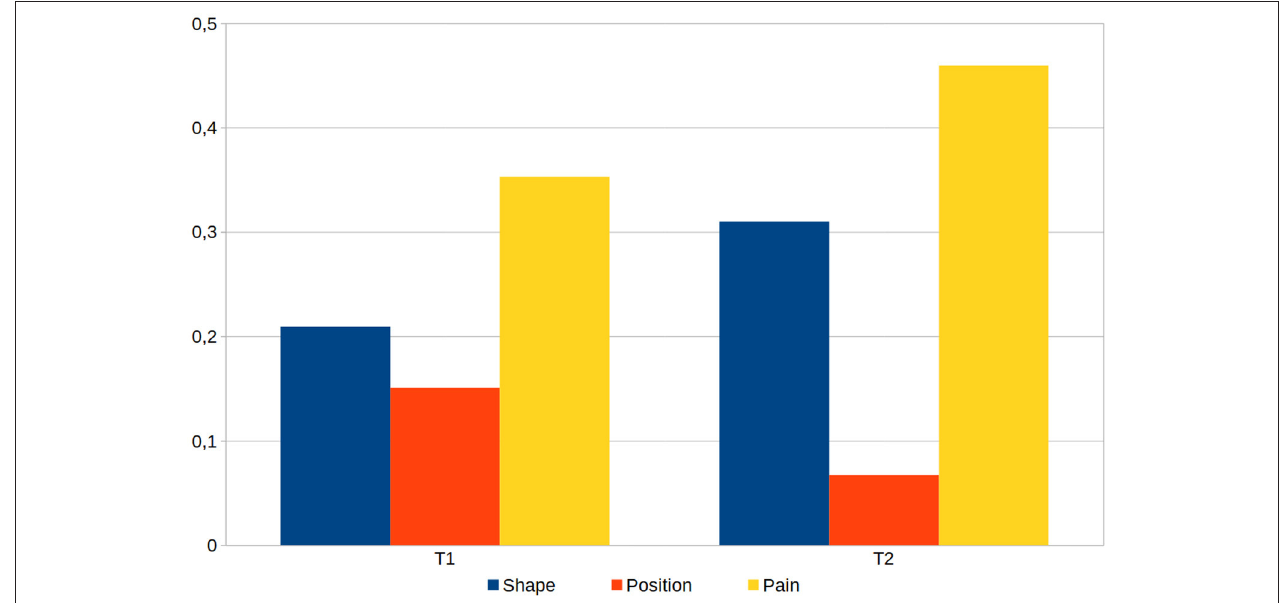
FIGURE 8 | The averaged coefficient of variance calculated for the three main aspects shape, position and pain, as determined from all 33 generated models for task 1 (T1) and task 2 (T2) of the therapist evaluation.